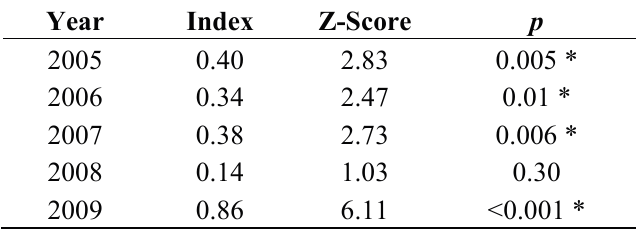
Table 2. Results of the Moran’s I spatial correlation analysis of the annual date of peak NDVI in each year from 2005 to 2009. * p < 0.05. The data from all pixels were used in the